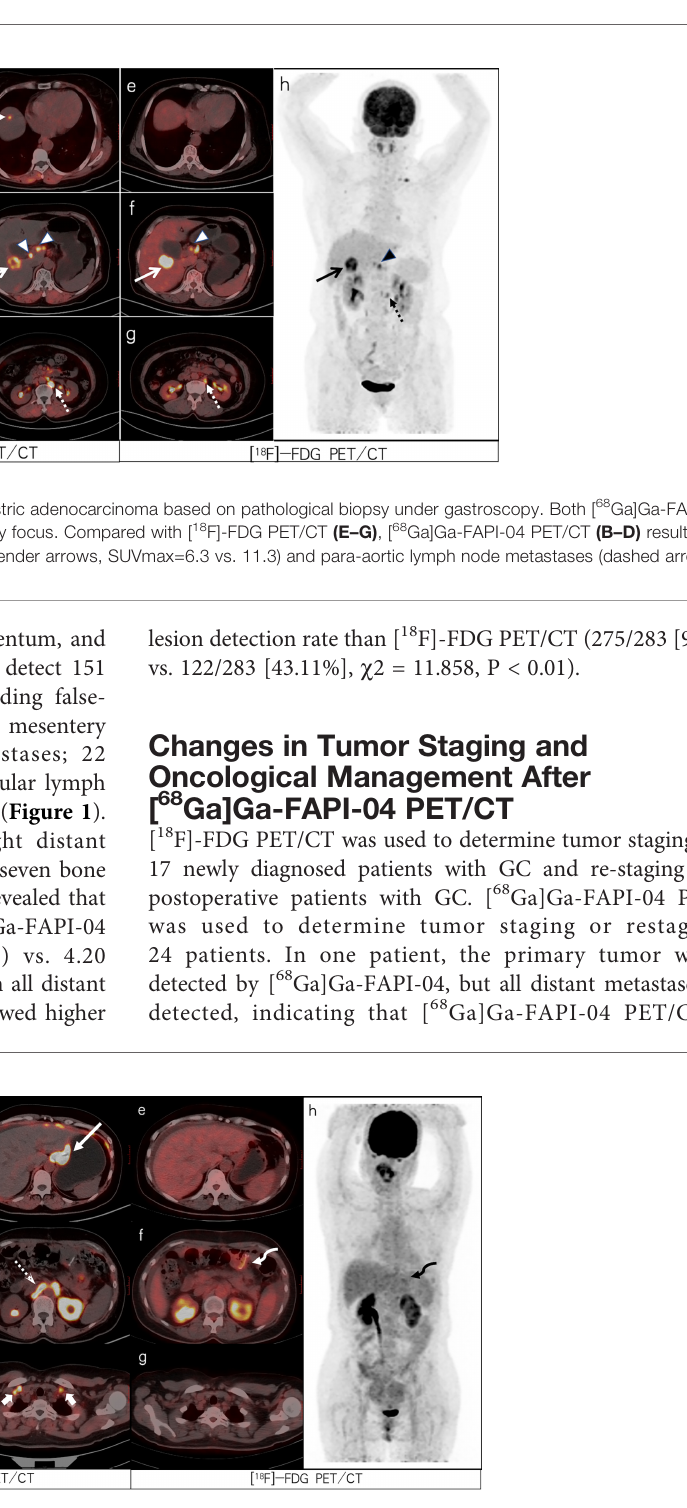
FIGURE 2 | A 47-year-old female patient with poorly differentiated gastric adenocarcinoma with partial signet ring cells based on pathological biopsy after operation. [ 68 Ga]Ga-FAPI-04 PET/CT (A – D) revealed high uptake in the gastric cardia (slender arrows, SUVmax=13.3), para-aortic lymph nodes (dashed arrows, SUVmax=15.7), and supraclavicular lymph nodes (short arrows, SUVmax=8.0) but negative uptake was observed on FDG PET/CT (E – H) . [ 18 F]-FDG PET/CT (F) revealed increased uptake in the gastric anastomosis (bent arrow, SUVmax=3.2) but negative uptake was observed on [ 68 Ga]Ga-FAPI-04 PET/CT (C) . The lesion was ultimately con fi rmed as residual gastritis by gastroscopic biopsy.